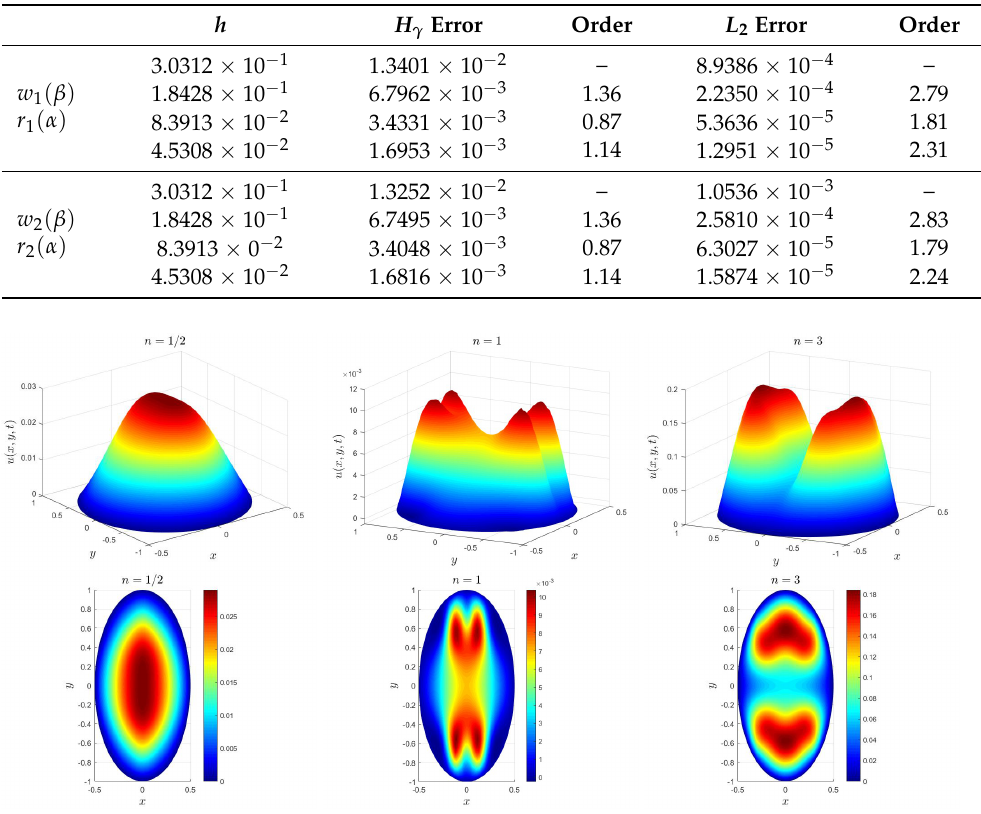
Figure 3. The three-dimensional and axial projection drawing particle distribution when n = 1/2, n = 1 and n =